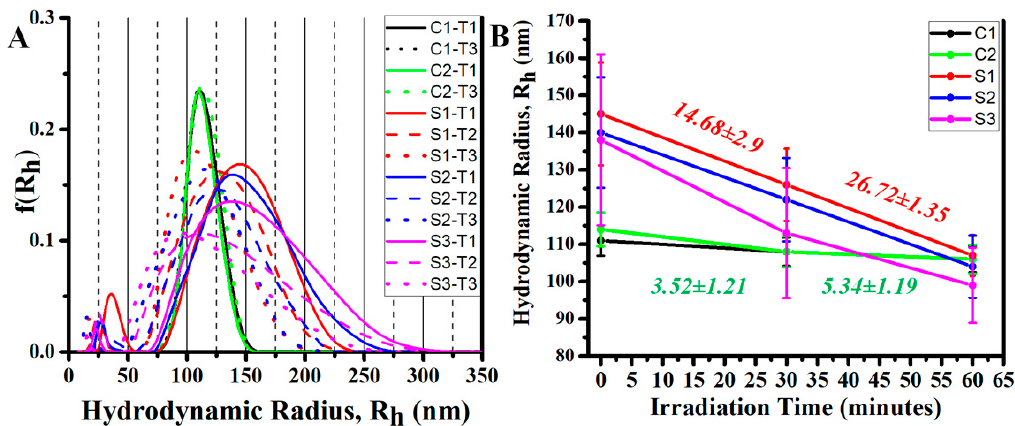
Figure 8. Demonstration of size shrinkage hybrid PNIPAm- co -allylamine microgels containing NIR-absorbing AuNM (hybrid microgels) on irradiation with NIR light source. ( A ) Light scattering data representing the changes in hydrodynamic radius of PNIPAm- co -allylamine microgels containing NIRAuNMs (S1–S3) vs. control microgels containing no AuNPs (C1–C2). S–irradiation cycle and T–irradiation time (0, 30, and 60 min). Control microgels data for two cycles of irradiation, whereas hybrid microgels are exposed to three cycles of irradiation. ( B ) Changes in hydrodynamic radius (Rh) of the hybrid microgels vs. irradiation time. C and S represent control and hybrid microgels, respectively, and 1, 2, and 3 represent cycles of irradiation.